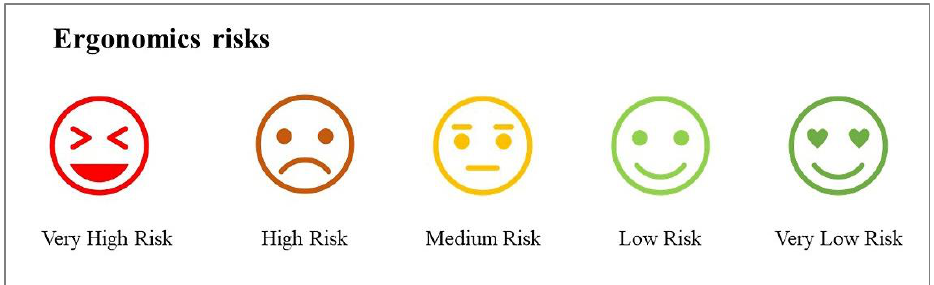
Figure 3. An extract of the visual questionnaire showing an OSH risk for obtaining risk perception scores.